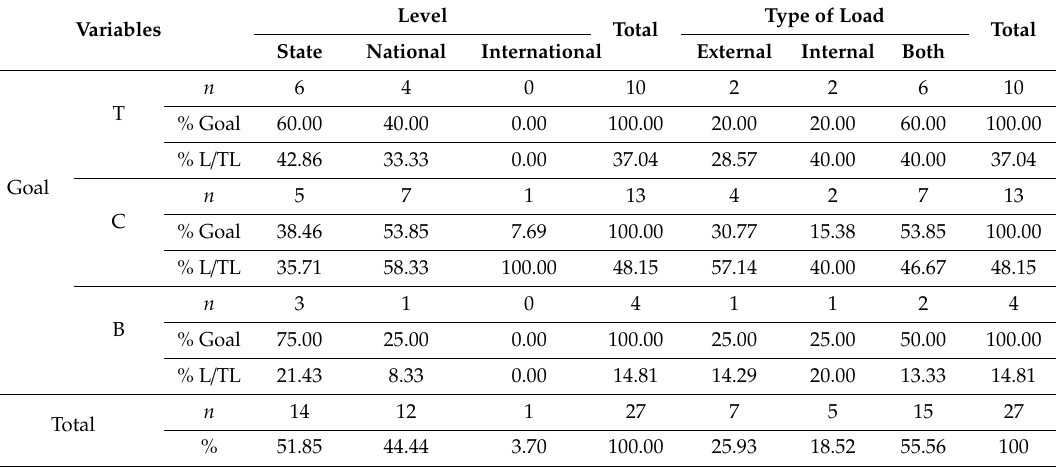
Table 1. Level and Type of Load by Goal.